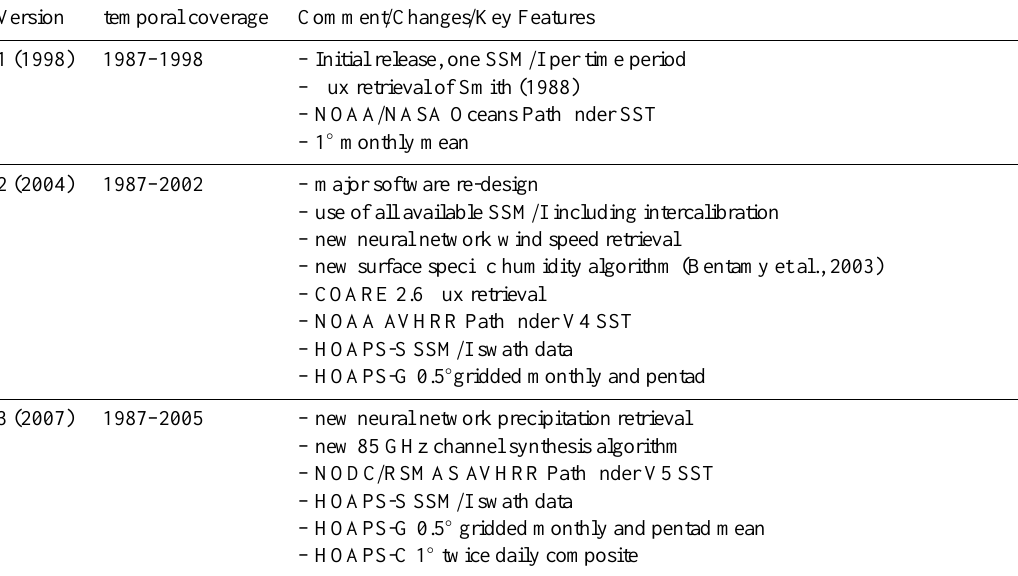
Table 1. HOAPS version